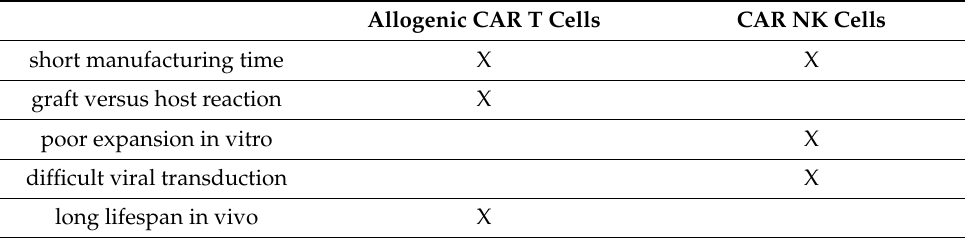
Table 2. Comparison of allogenic CAR T and CAR NK